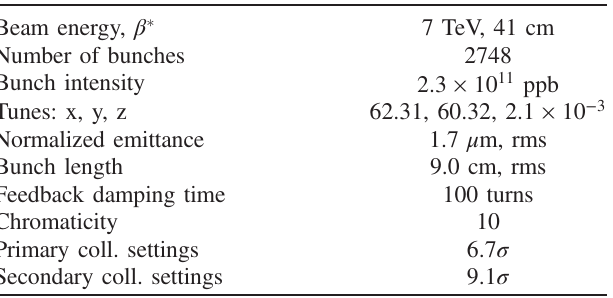
TABLE IV. Key beam and machine parameters used for numerical simulations. Collimator settings are defined for a 2 . 5 μ m rms reference normalized emittance.